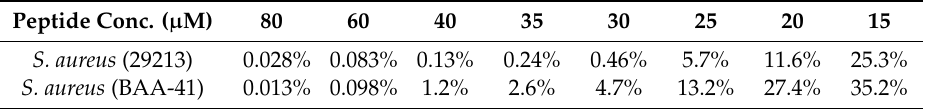
Table 7. Percentage reduction of viable bacterial cells of S. aureus biofilms including the minimum biofilm bactericidal concentration (MBCb) for A3 against tested bacterial strains. Peptide Conc. ( µ M)